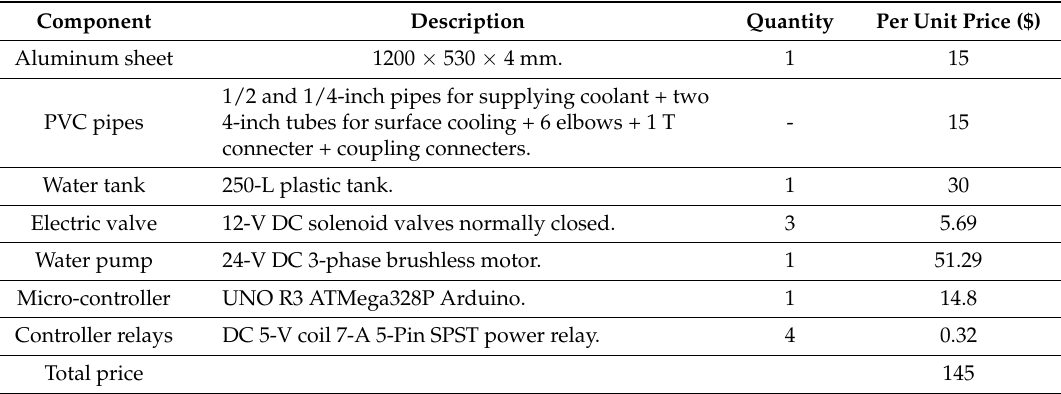
Table 3. List of components for the cooling